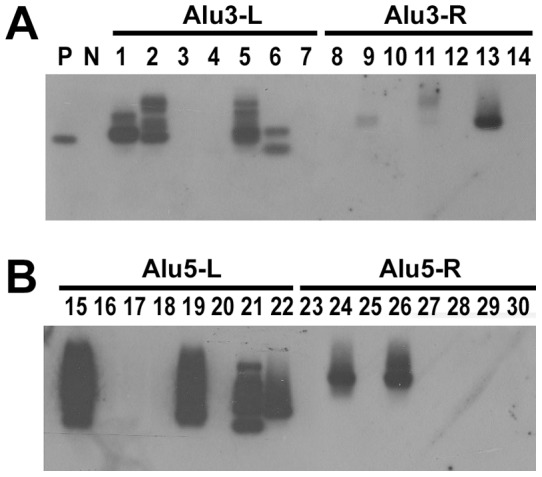
Southern blot analysis of Alu-PCR amplicons.Four sets of Alu-PCR were performed (See Table 1). (A and B) Alu3-L, Alu3-R, Alu5-L, and Alu5-R were the PCR products generated using primers Alu3/PCFo, Alu3/PCRo, Alu5/PCFo, and Alu5/PCRo respectively as the first stage PCR primers and Tag3/PCFi, Tag3/PCRi, Tag5/PCFi, and Tag5/PCRi respectively as the second stage PCR primers. The filter was hybridized with a digoxigenine-labeled HBV specific probe.